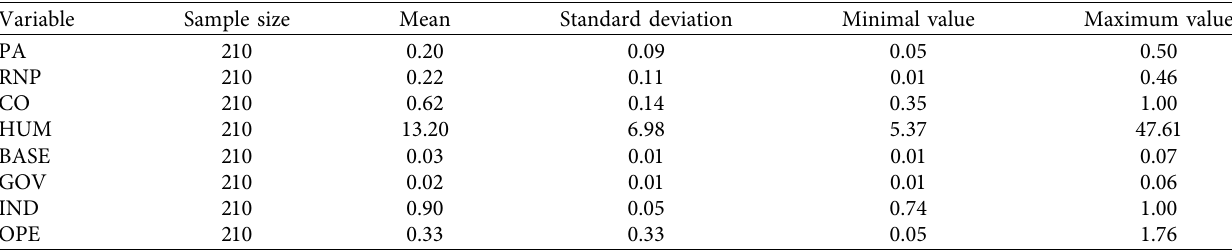
Table 3: Statistical description of each variable.